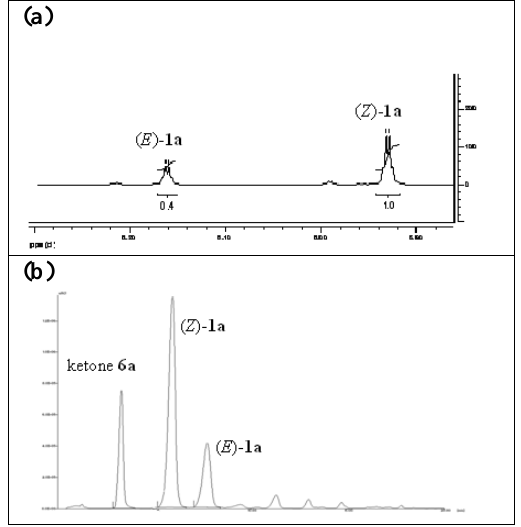
Figure 2. (a) NMR spectrum of crude 1a ranging from  = 5.80 ppm to  = 6.25 ppm; (b) Chromatographic profile of crude 1a